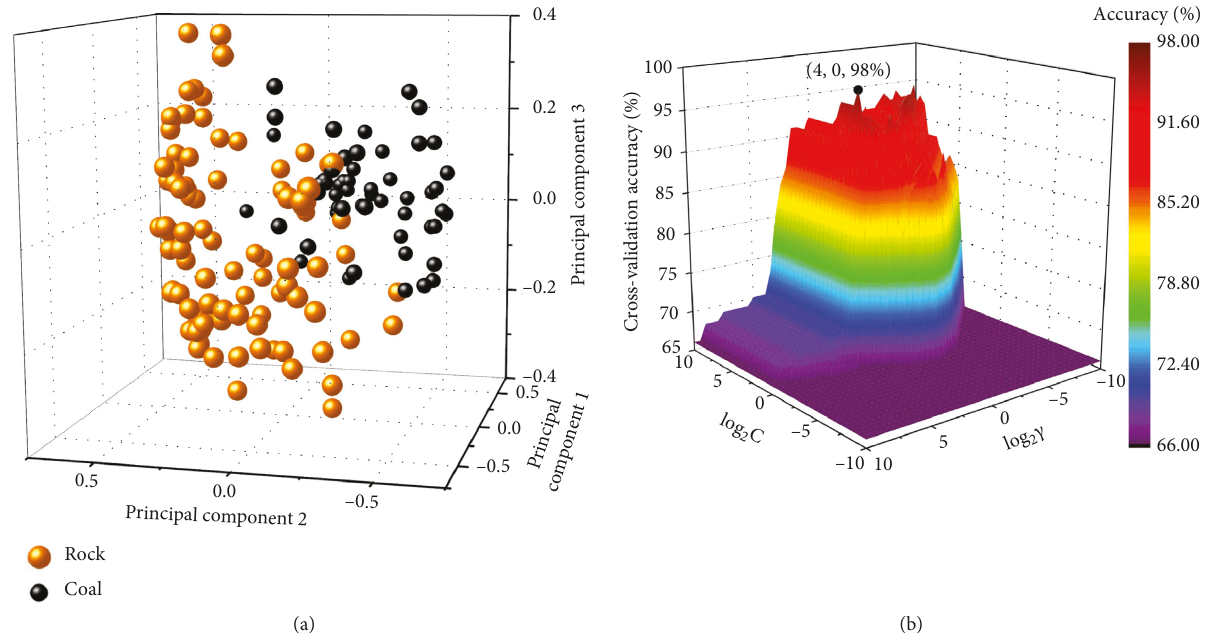
Figure 10: (a) 3D spatial distribution of the first three PCs of CR spectra of the 150 training samples in the eight regions in Table 1 through GRB-KPCA ( σ � 63); (b) process of searching for the optimal penalty parameter c and radial basis function variance parameter c of GRB- KPCA-SVM model through cross validation with the first ten PCs as input variables.